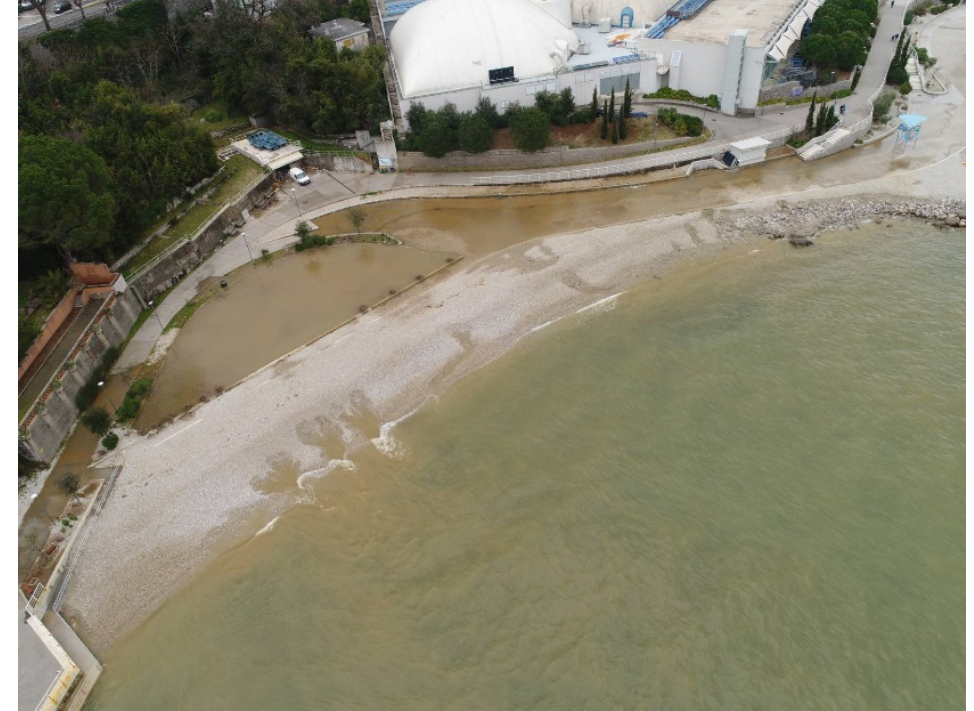
Figure 10. Flooding and outbursts on the beach, 2 March 2020.